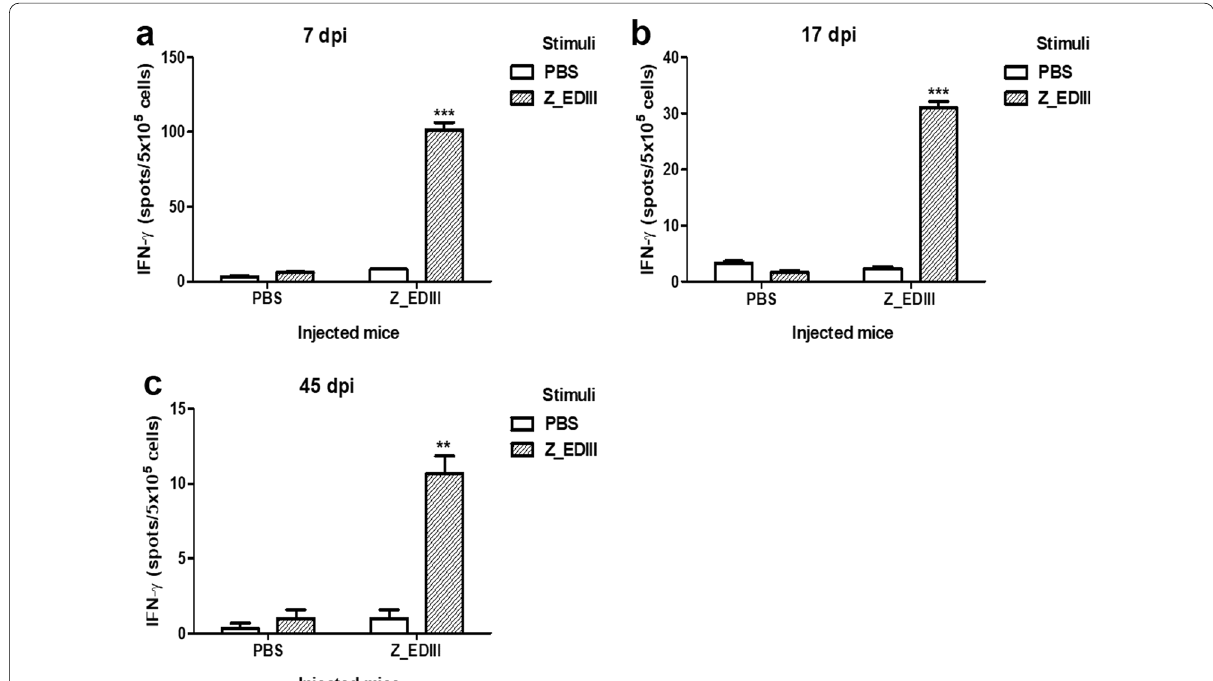
Fig. 4 Number of IFN‑γ‑secreting splenocytes in immunized mice. C57BL/6 mice ( n dpi. Mice were euthanized 7, 17, and 45 dpi (7 dpi; a , 17 dpi; b , 45 dpi; c ). Splenocytes were stimulated with Z_EDIII (10 μg/ml) or PBS. Ag‑specific